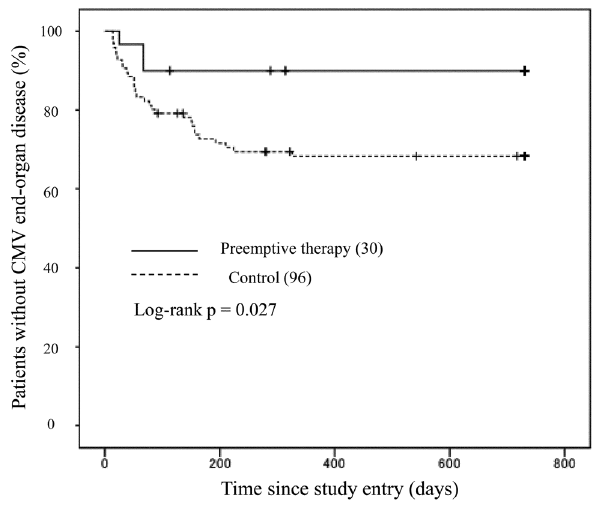
Figure 2. Kaplan-Meier curve showing the time to develop- ment of cytomegalovirus (CMV)- end-organ disease (EOD) in the preemptive and non-preemptive therapy groups. Compared to patients on CMV preemptive therapy, those who did not receive preemptive therapy were more likely to develop CMV-EOD (p=0.027, Log-rank test).